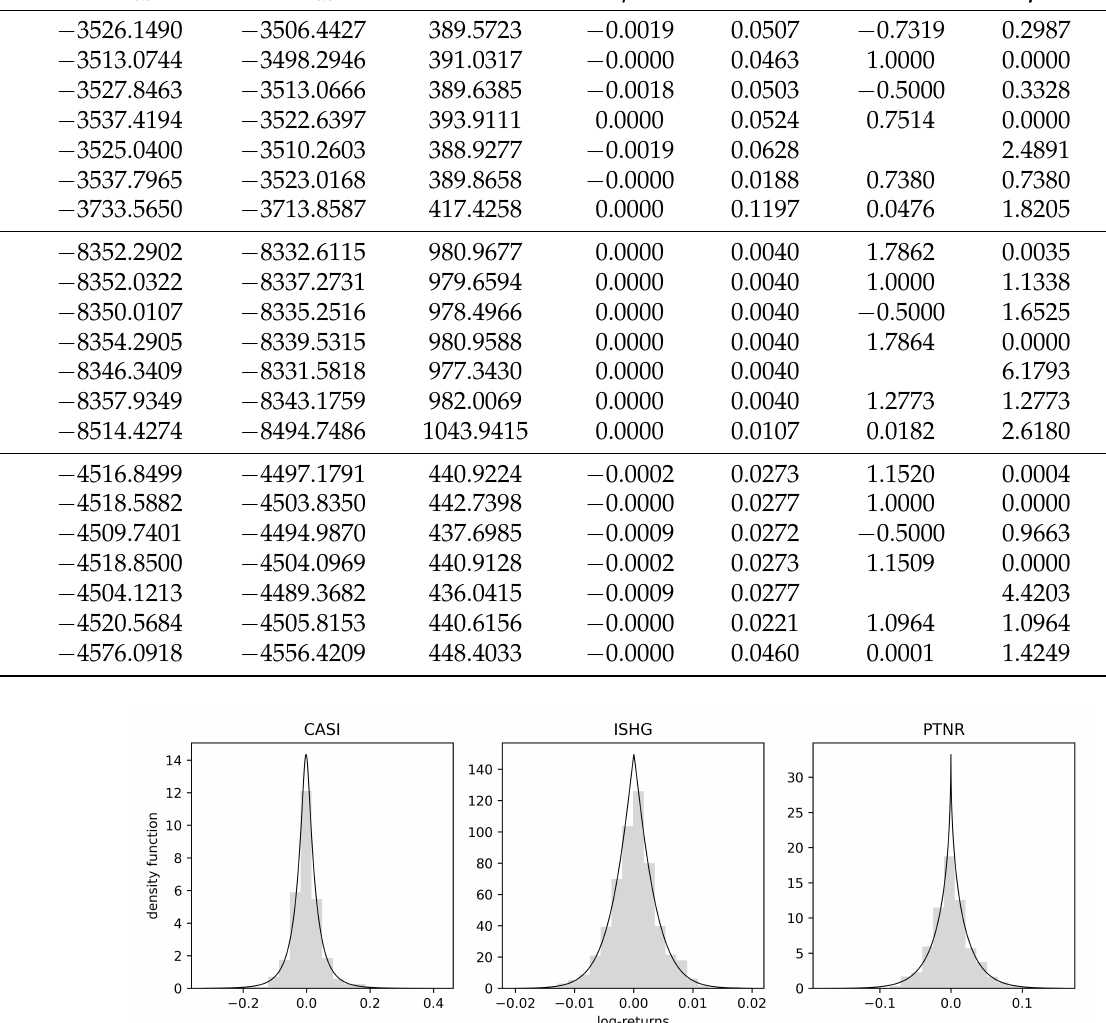
Figure 7. Fitted BTGN density functions to log-returns